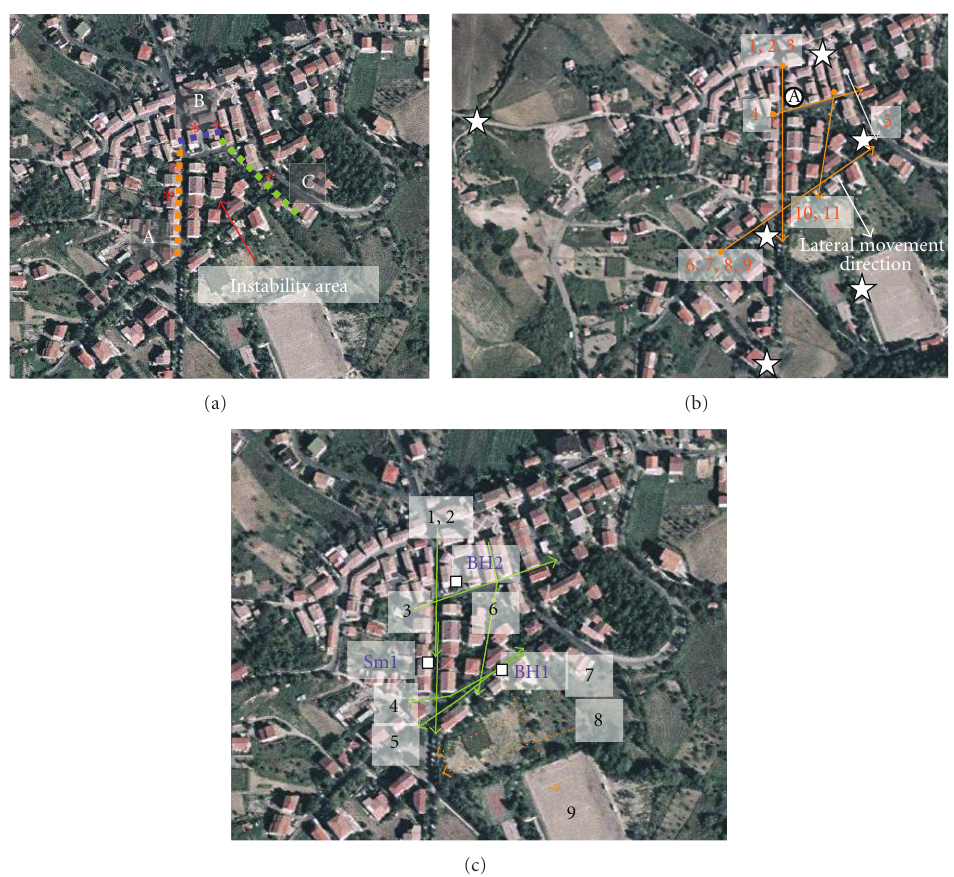
Figure 5: (a) Location of main crack patterns lying more or less normal to each other, the buildings with the greatest damage are marked with stars. (b) White circles and stars indicate location of topographic survey: stars indicate steady points and circles unsteady ones. Orange lines are the location of seismic refraction surveys. (c) Borehole locations are indicated with white squares and electric resistivity tomography with green and orange dot